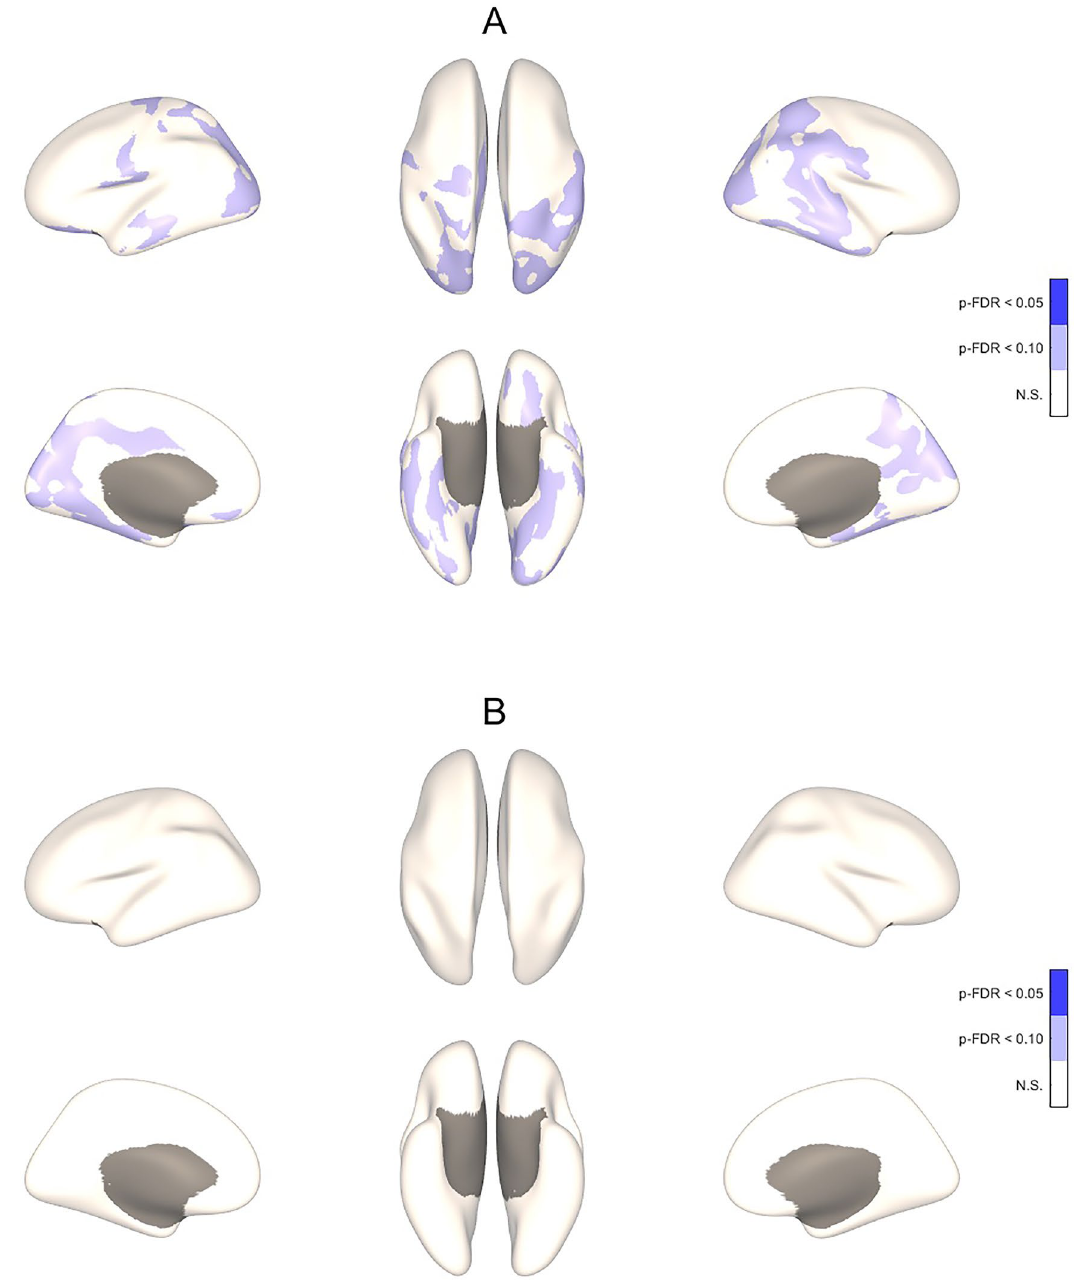
Figure 1. 3-D Maps Showing Correlation Between ScreenQ Scores and Cortical Thickness for the Whole Brain. Three-dimensional maps showing correlations between ScreenQ total scores and cortical thickness for the whole cerebrum, controlling for age and sex ( A ) and also for maternal education ( B ). These are displayed on an inflated brain for better visibility of clusters, with blue representing thinner cortex. Upper views are lateral and superior, lower views are medial and inferior, with the frontal lobe facing upward. Cortical regions surviving p-FDR < 0.10 and shown in ( A ) are detailed in Table stimuli 55 . Whether this finding reflects accelerated maturation via more frequent and/or stimulating screen-based media use, or under-development via less exposure to non-screen stimuli (e.g., shared reading) is unclear and in need of further study. By contrast to primary visual areas, lower CT in the lingual gyrus, which is considered to be a higher-order visual-association area, was left-lateralized (especially ROI-based, Fig. 3), suggesting asynchronous thinning that tends to occur in these specialized brain areas. Adjacent to the parahippocampus, the lingual gyrus is involved with complex visual memory encoding, including facial and emotional expressions, core social-cognitive processes 56 . Lower CT in the lingual gyrus has been linked to lower episodic memory and social cognition in adults 57 . The lingual gyrus has also been found to support printed letter recognition, a pre-reading skill that